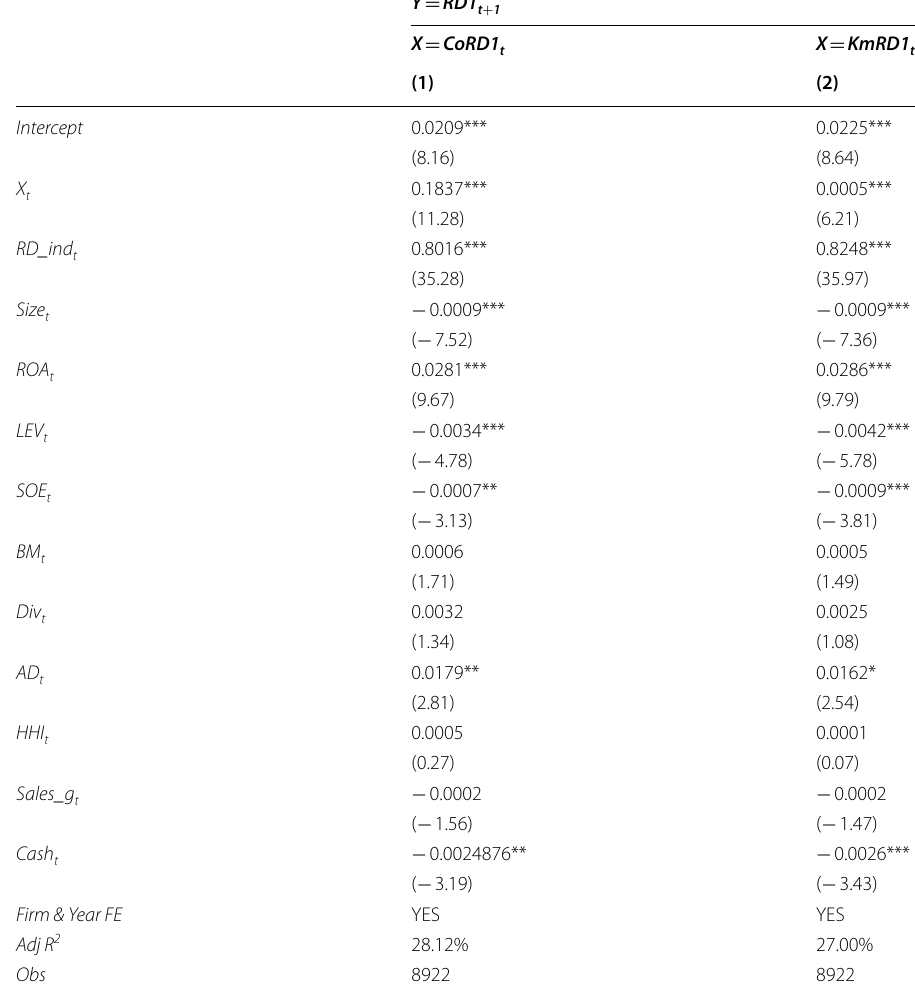
Table 5 Regression results of the overall